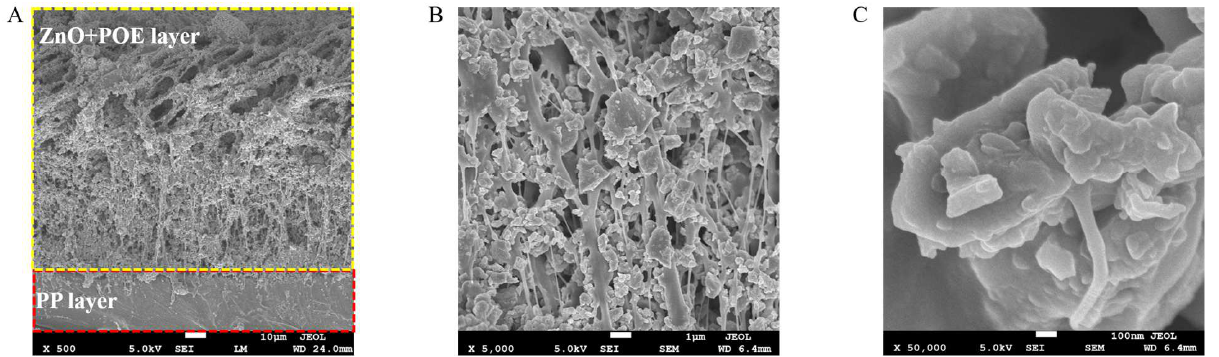
Figure 4. SEM photos of cross section of ZnO layer at different magnifications. ( A ) The scale is 1 mm. ( B ) The scale is 1 μm. ( C ) The scale is 100 μm.